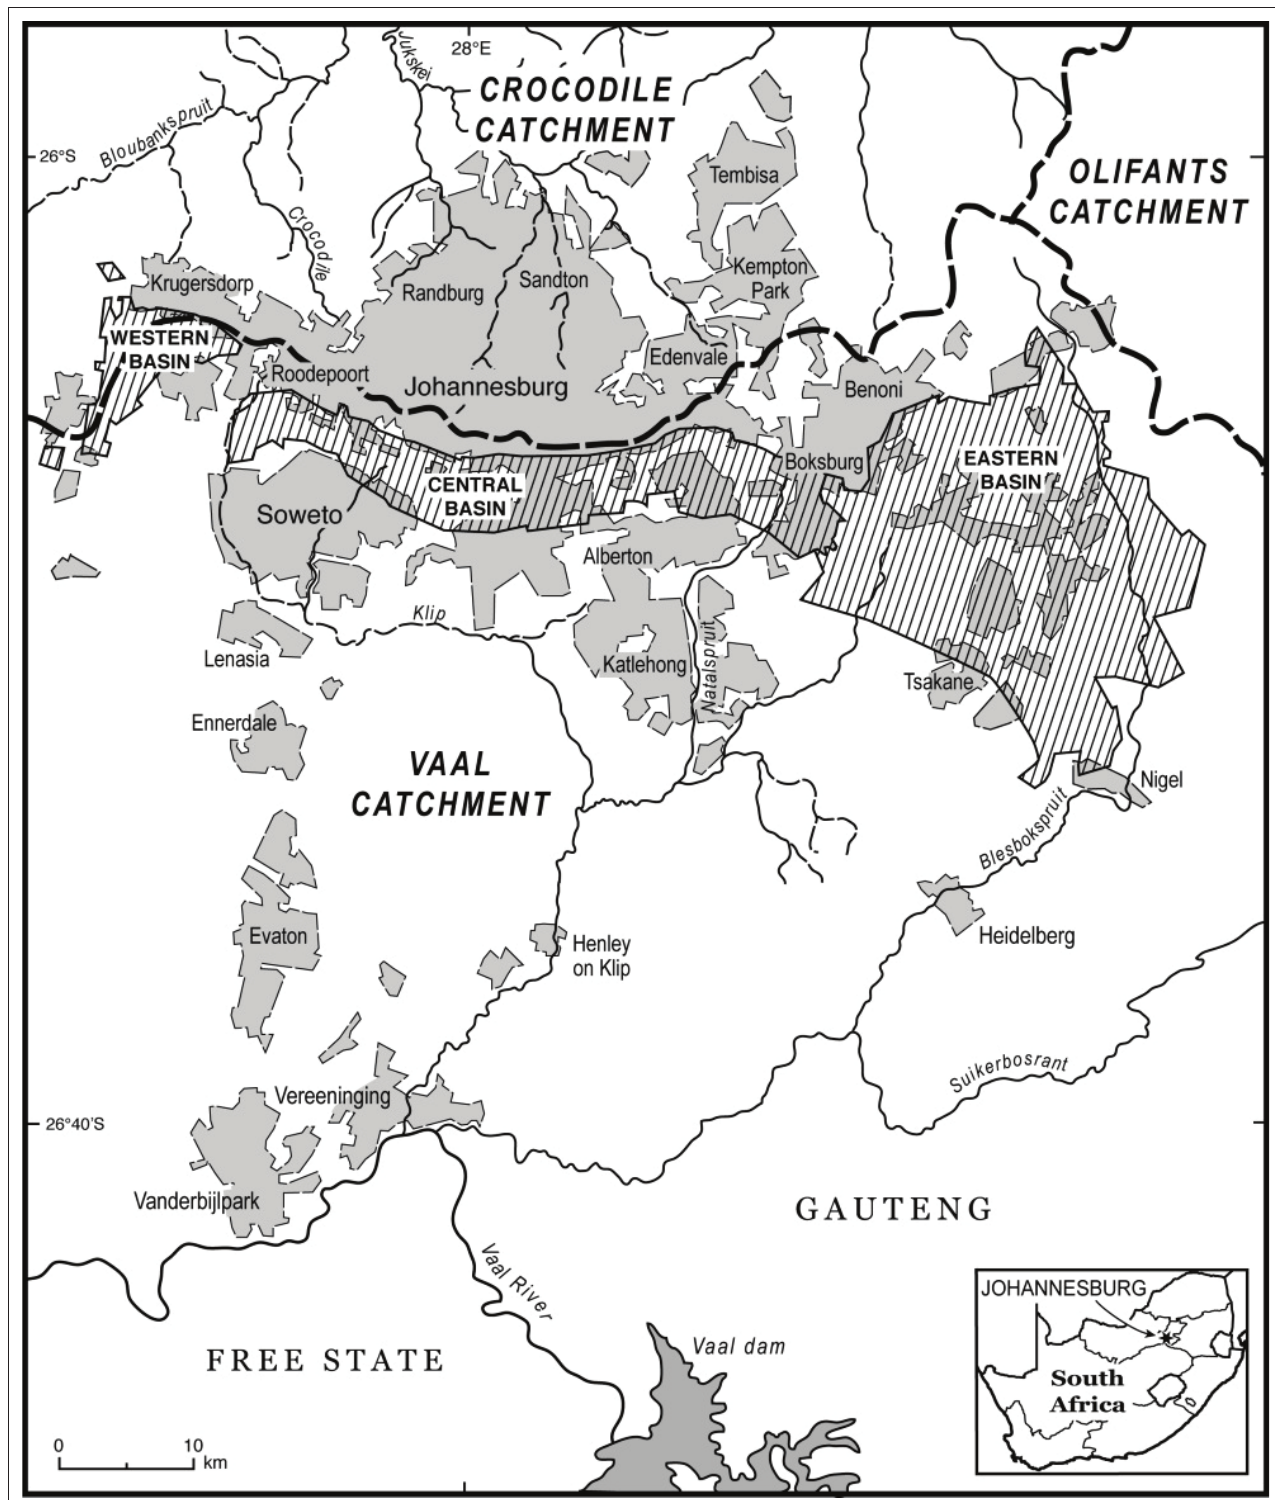
FIGURE 2: The three Witwatersrand sub-basins and the associated water catchment areas of the Upper